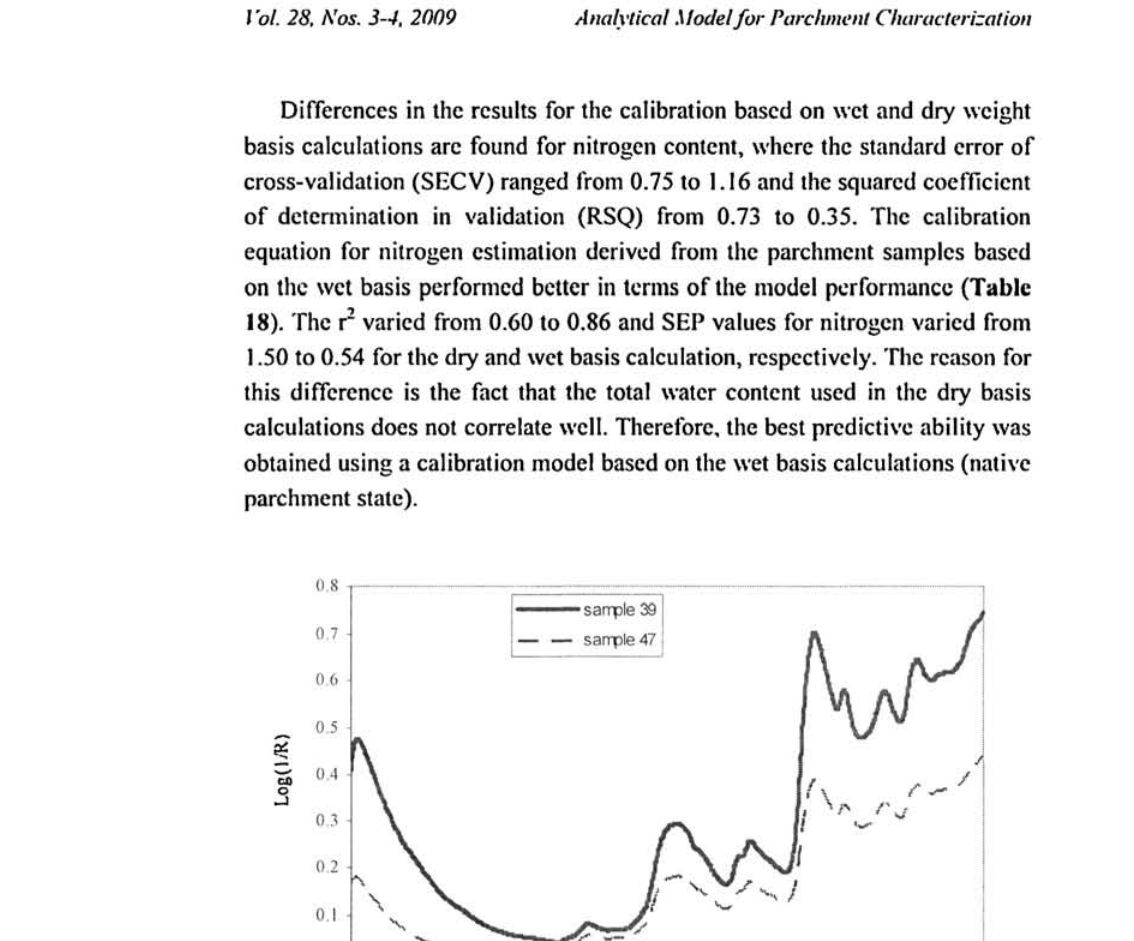
Fig. 86: Near infrared spectra of parchment samples with different water content (upper-high content, lower-low content), sample 39-flesh side, sample 47-grain